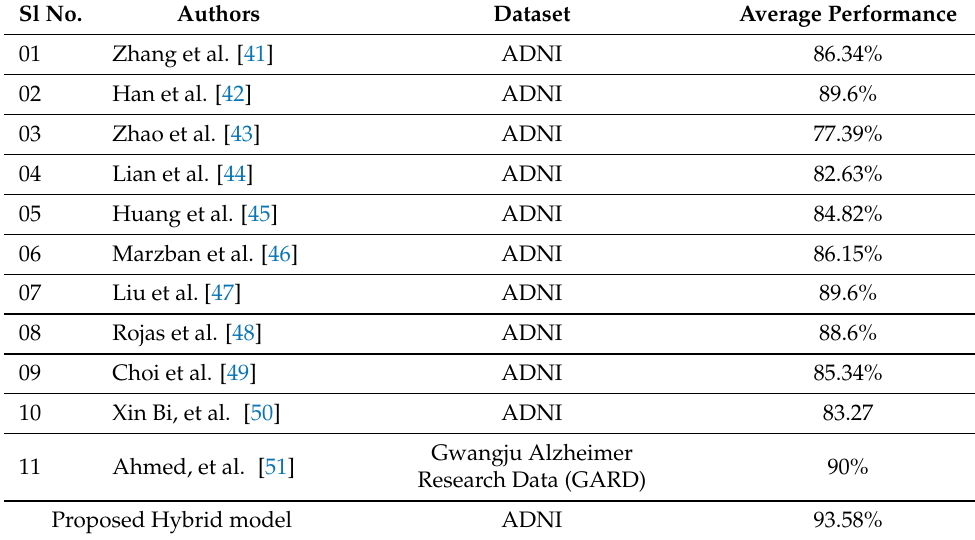
Table 6. Performance comparison amongst the discussed AD classification approaches. Sl